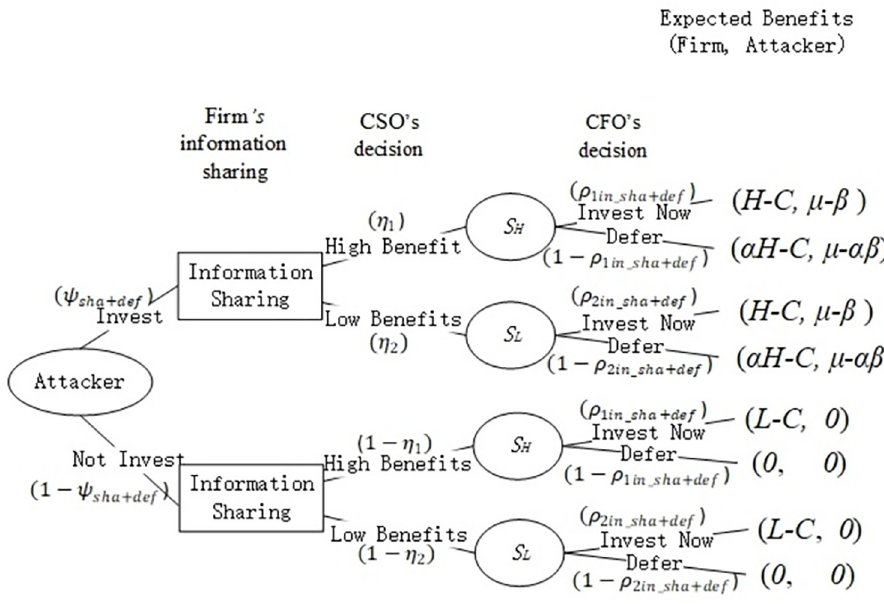
Fig 4. Game tree in the presence of information sharing and deferral